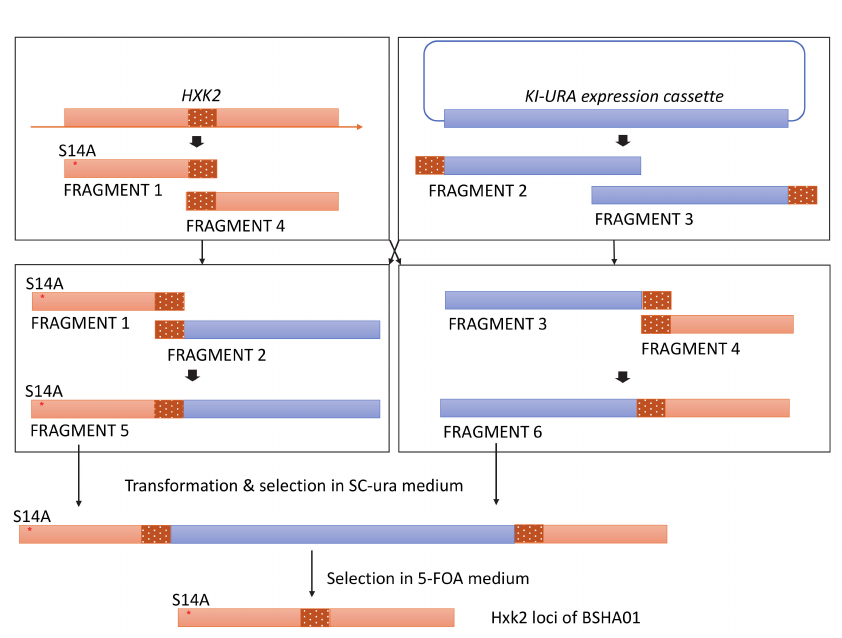
Figure A1. Construction process diagram of the strain